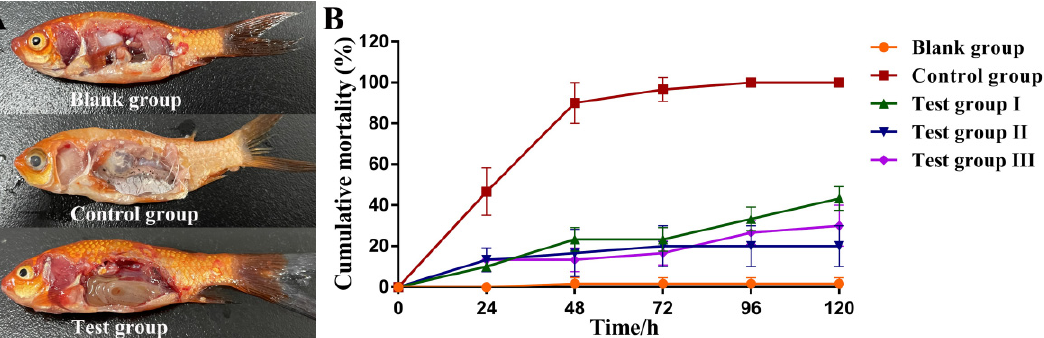
Figure 8. The internal organs and cumulative mortality curves of brocade carps ( Cyprinus aka Koi) in the blank group, control group, and test groups. Each fish in the blank group was successively injected intraperitoneally twice with 0.01 M PBS. Each fish in the control group was successively injected intraperitoneally with A. hydrophila A18 (10 8 CFU/mL) and 0.01 M PBS. Each fish in the test group I was successively injected intraperitoneally with A. hydrophila A18 (10 8 CFU/mL) and Aeromonas phage Ahy-yong1 (10 7 PFU/mL). Each fish in the test group II was successively injected intraperitoneally with Aeromonas phage Ahy-yong1 (10 7 PFU/mL) and A. hydrophila A18 (10 8 CFU/mL). The injection time intervals were 2 h and the injection volume was 100 μ L. Each fish in the test group III was injected with 100 µ L of Aeromonas phage Ahy-yong1 (10 7 PFU/mL) immediately after the injection of 100 µ L of A. hydrophila A18 (10 8 CFU/mL). ( A ) The internal organs of brocade carps infected with A. hydrophila (control groups) were swollen and rotten and their eyes become cloudy relative to the blank groups and test groups. ( B ) The cumulative mortality of brocade carps in the blank groups was 1.7% ± 2.4%. The cumulative mortality of brocade carps in the test groups I, II, and III were 43.3% ± 4.7%, 20.0% ± 8.2%, and 30.0% ± 8.2%, respectively, which were significantly lower than those in the control groups, of which the cumulative mortality was 100.0%. All values represent the mean of triplicate measurements, and error bars represent the standard deviations ( n =